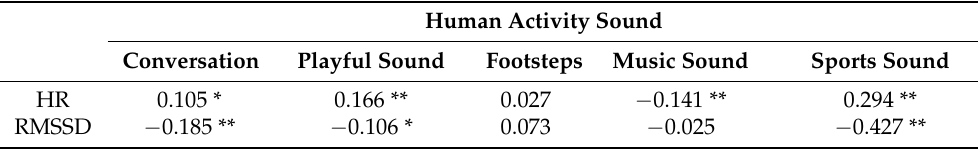
Table 7. Pearson correlation between human activity sound and heart rate variability in the park.